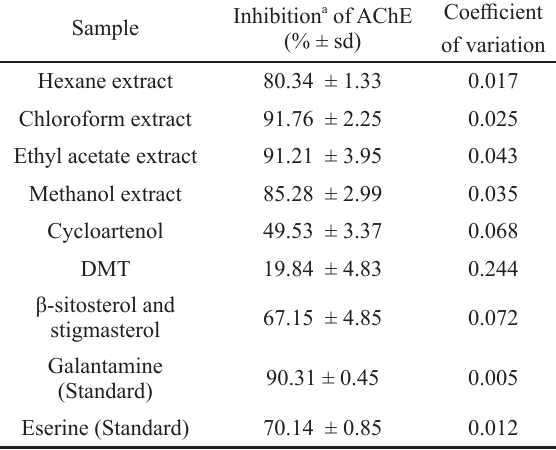
Percent inhibition of acetylcholinesterase (aChe) induced by substances isolated from leaves of P.